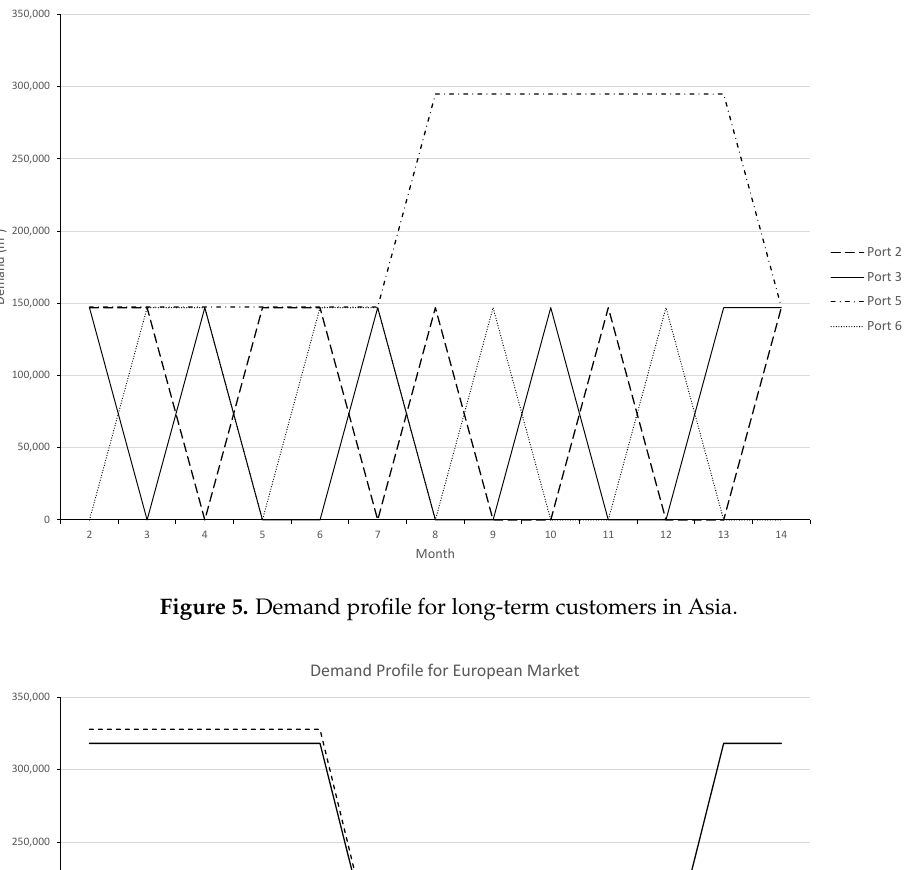
Figure 5. Demand profile for long-term customers in Asia.